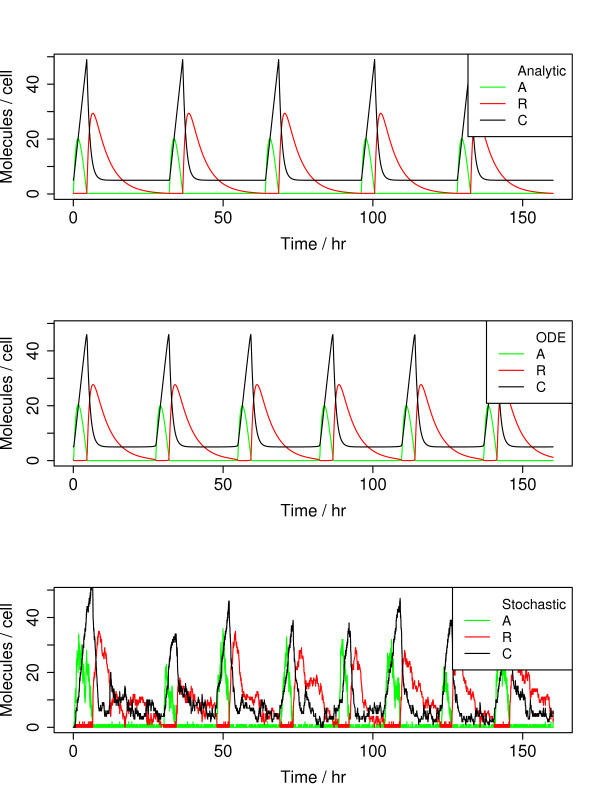
Trajectories of activator, repressor, and complex concentrations are displayed for dynamics from analytical expressions (top panel), continuous ODEs (middle), and stochastic simulations (bottom). Parameter values are the default values from Table 1, essentially identical to those in Ref. [11] but with Hill coefficient = 2 and concentrations reduced by 50×.